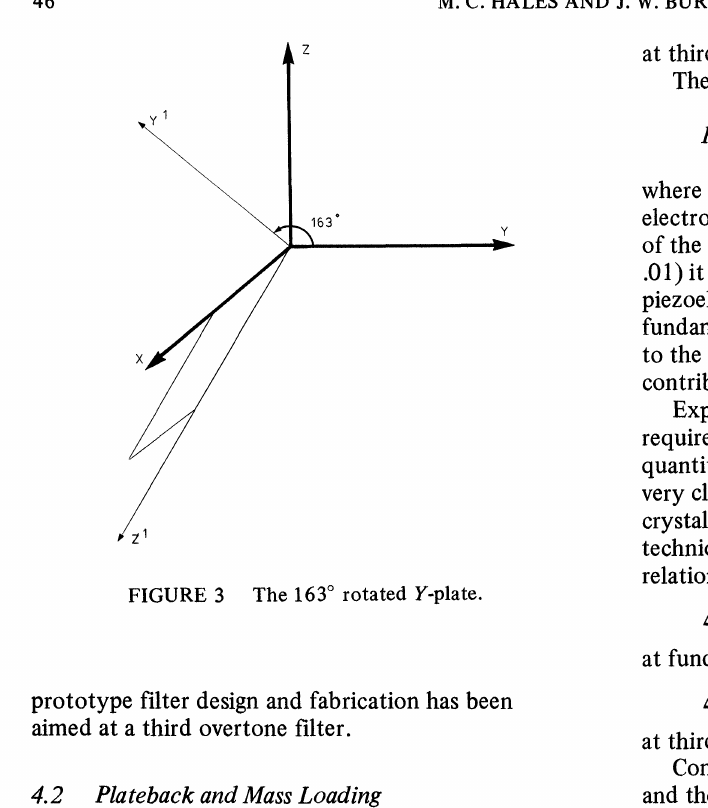
FIGURE 3 The 163 rotated